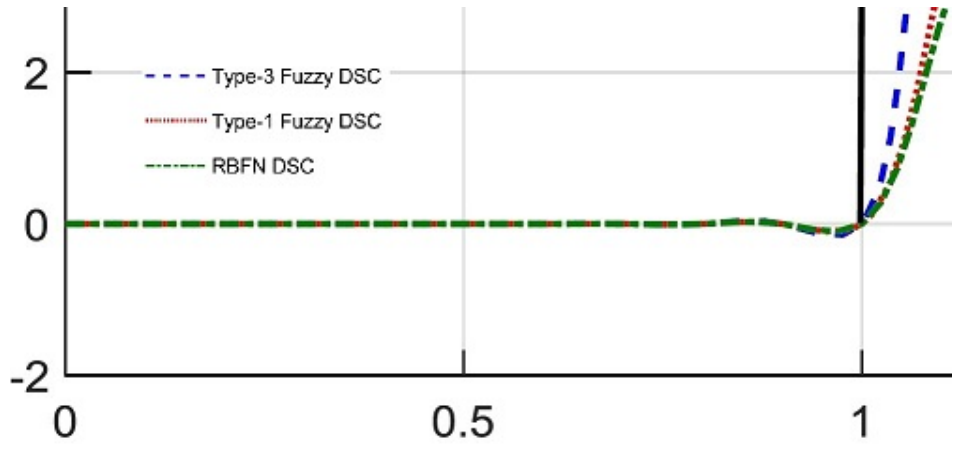
Figure 11. A closer view of Figure 10.